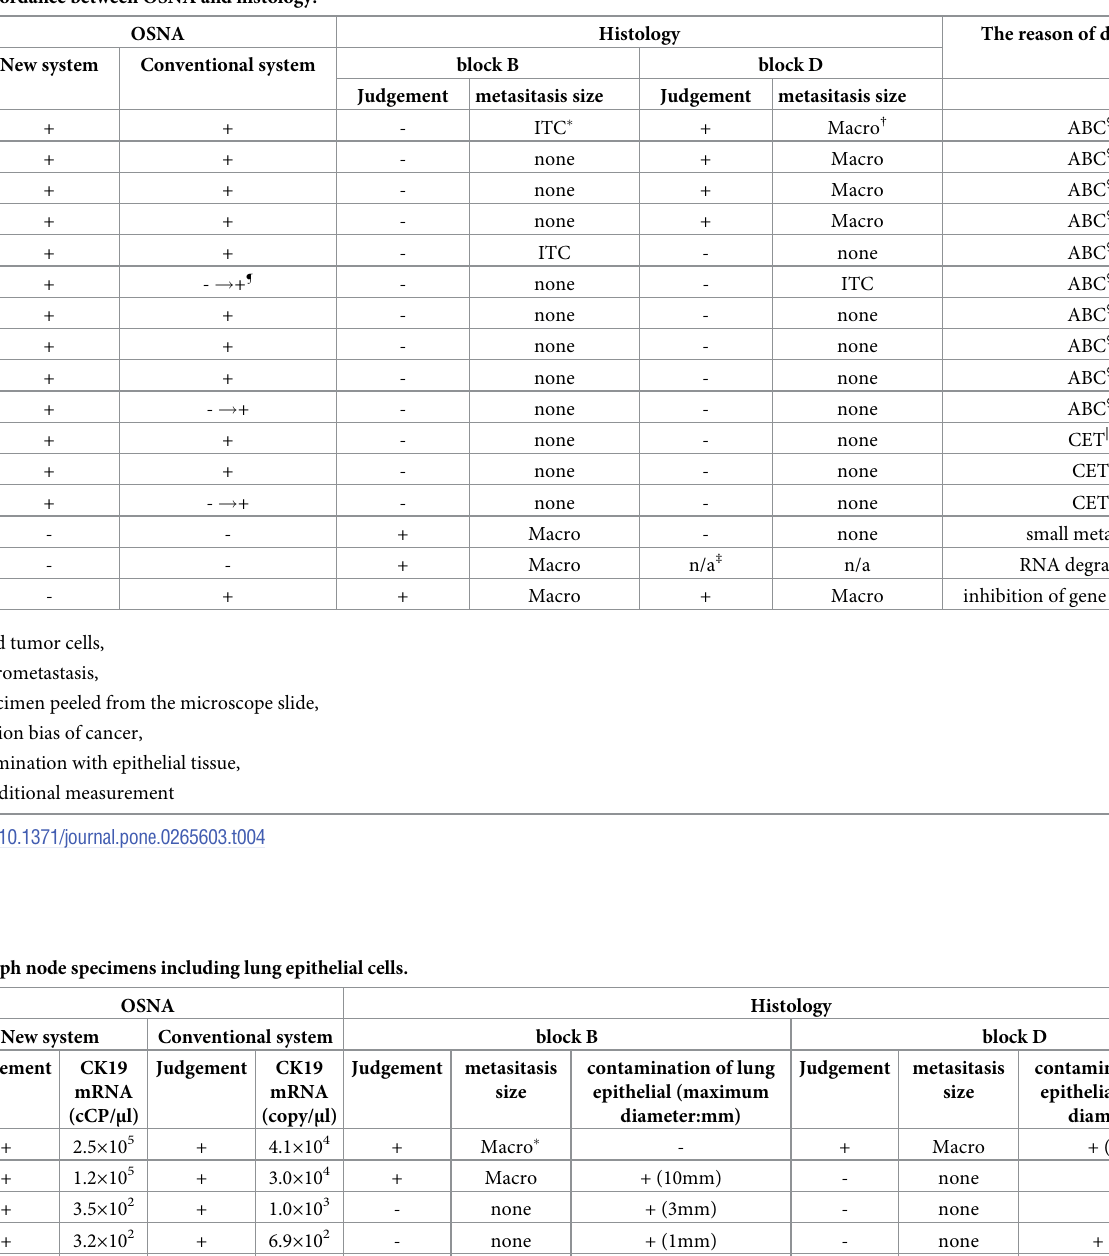
Table 4. Discordance between OSNA and histology. LN